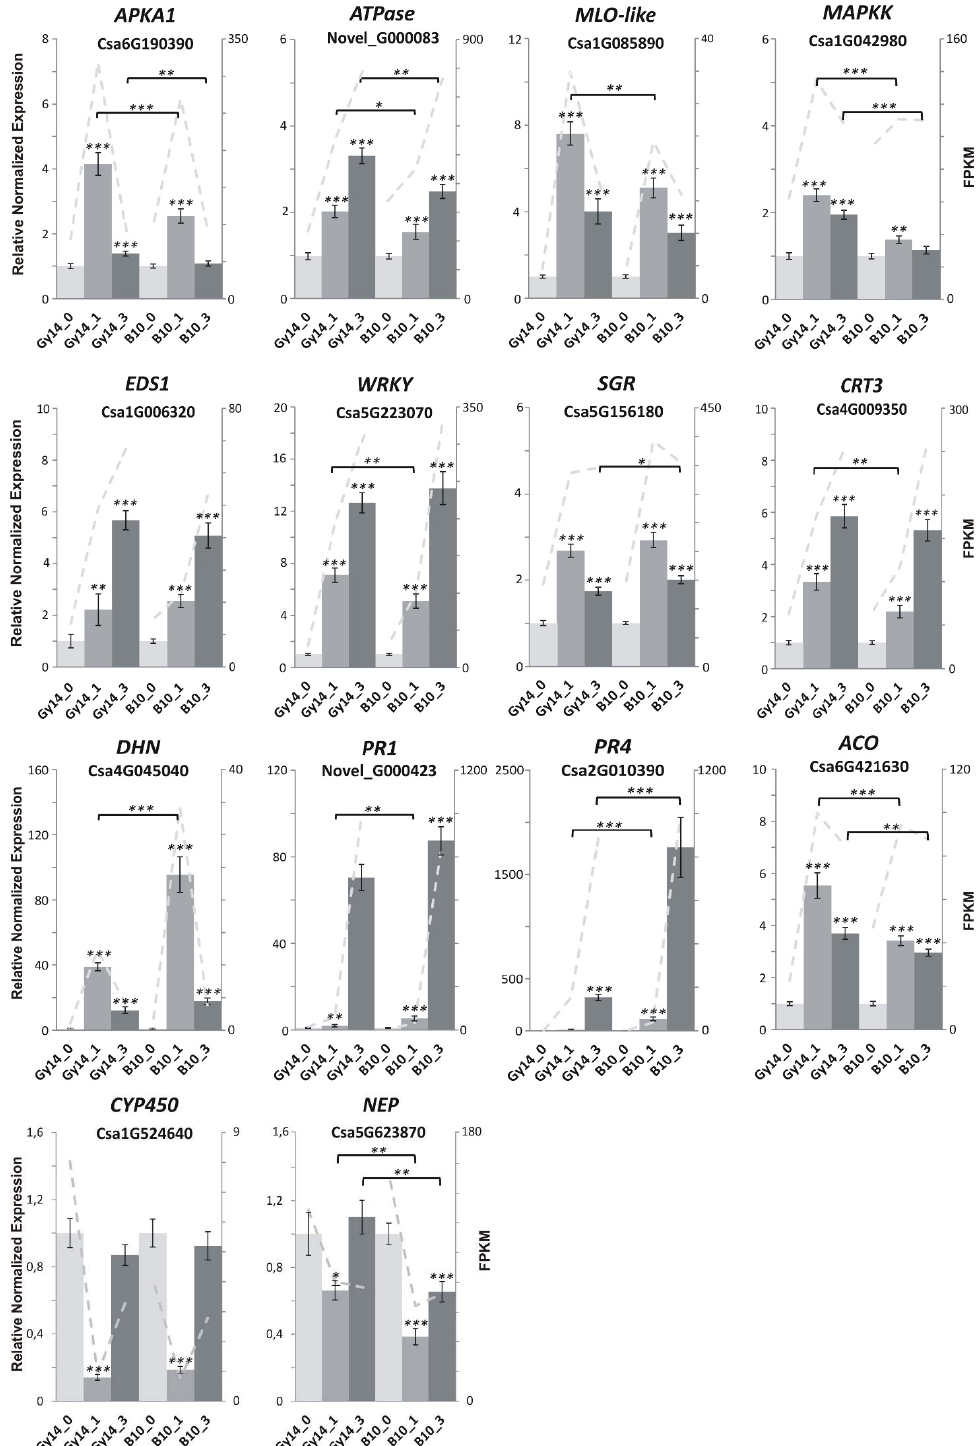
Figure 5. The expression of 14 selected differentially expressed genes (DEGs) for lines Gy14 and B10 at 0, 1 and 3 dpi. Diagrams show relative normalized gene expression level ± SEM revealed by RT-qPCR from 3 biological and 3 technical replicates. For data normalization, 2 reference genes CACS and TIP41 were used. Grey dashed line represents estimated numbers of fragments per kilobase million (FPKM). Full gene names are provided in Supplementary Table S3. Significance levels were calculated with Student’s t -test: p < 0.05 (*), p < 0.01 (**) and p < 0.001 (***). Abbreviations: B10_0–B10 line at 0 dpi (control), B10_1–B10 line at 1 dpi, B10_3–B10 line at 3 dpi, Gy14_0–Gy14 line at 0 dpi (control), Gy14_1–Gy14 line at 1 dpi, Gy14_3–Gy14 line at 3